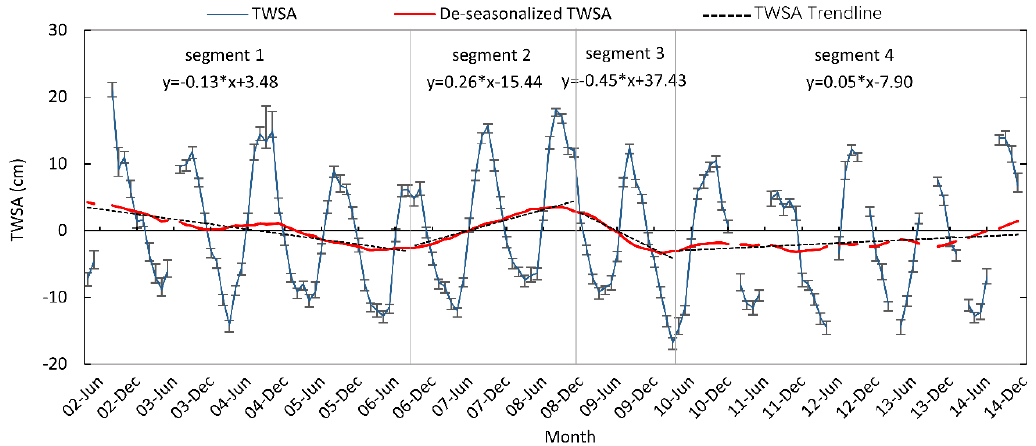
Figure 2. Monthly average Total Water Storage Anomalies of all grids of Yunnan Province from April 2002 to November 2014 (solid blue line). The solid red line is the de-seasonalized and smoothed TWSA. The black dashed lines are the linear trends of the de-seasonalized TWSA during the first big dry period, big wet period, second big dry period and fluctuating period, respectively. The error bars indicate the standard deviations among the three Gravity Recovery and Climate Experiment (GRACE) datasets, provided by the Center for Space Research at University of Texas, Austin (CSR), Jet Propulsion Laboratory (JPL) and GeoforschungsZentrum Potsdam (GFZ). The month without data is vacant.